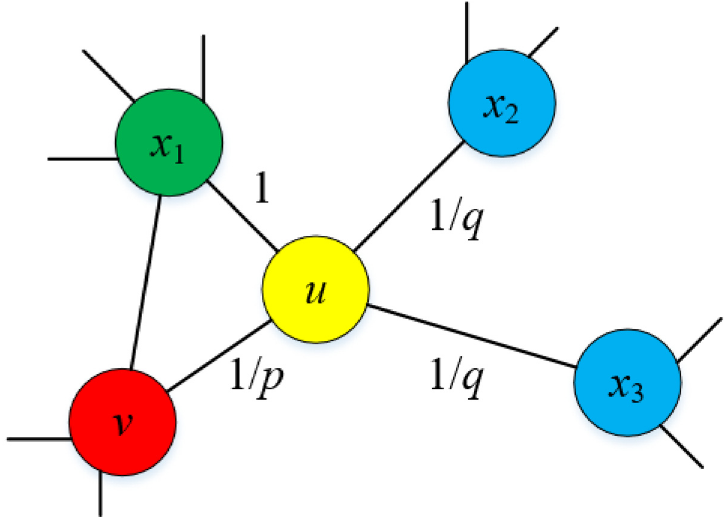
Fig 4. Illustration of the random walk procedure in node2vec. This randomwalk just traverses from v to u and now is evaluating its next move out of the node u . Edge label indicates the correspondingsearch biases α pq